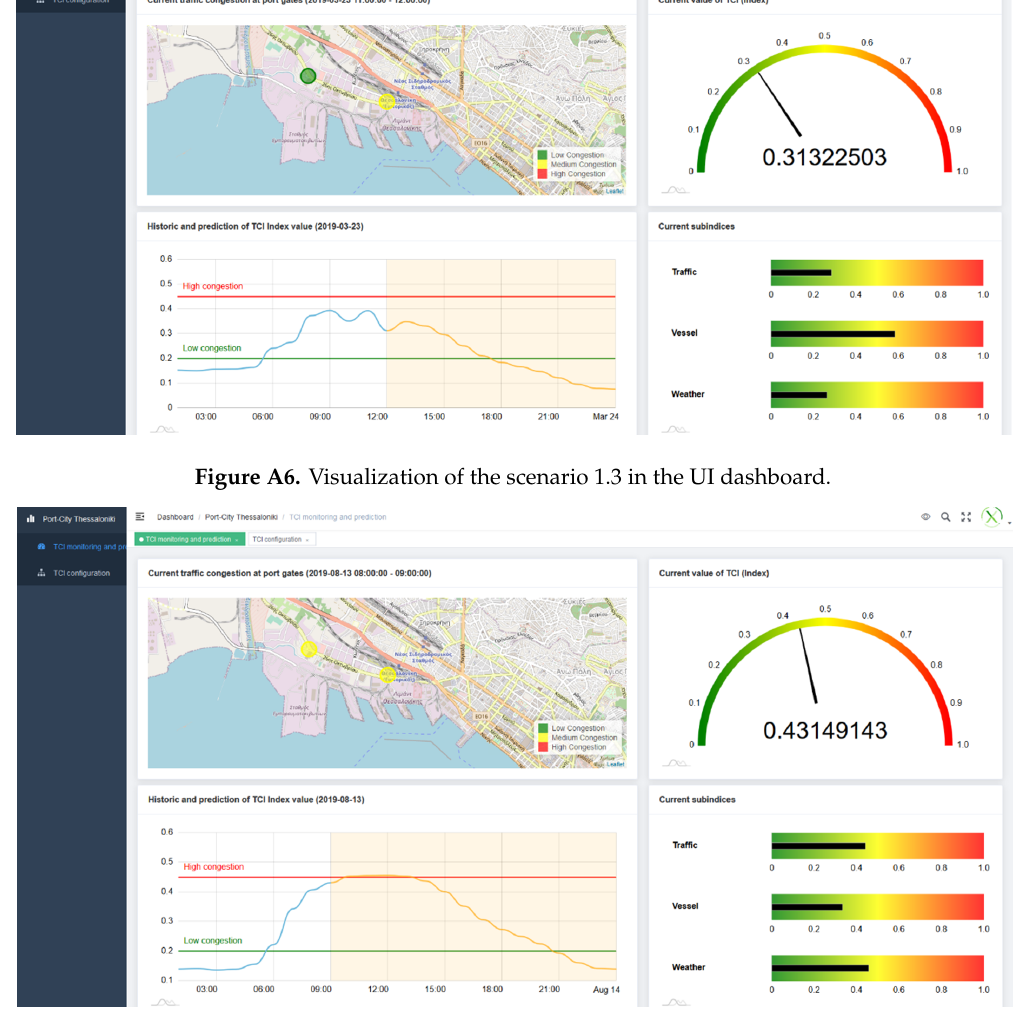
Figure A7. Visualization of the scenario 2.1 in the UI dashboard.